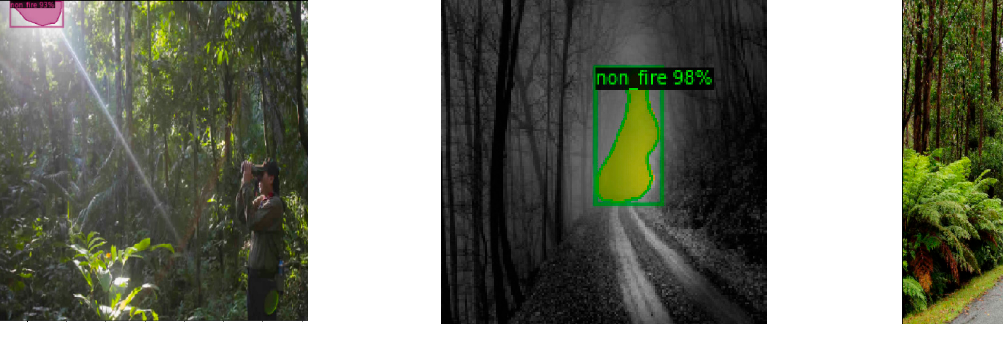
Figure 15. Limitation results for day and night non-fire images.